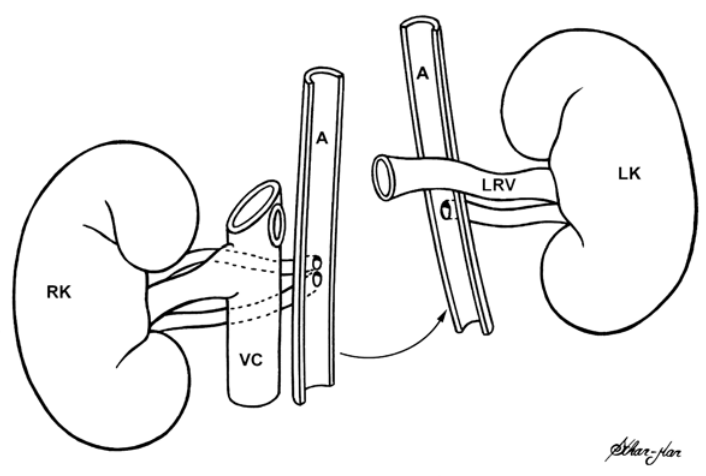
Figure 1 – Folding longitudinal split aorta and separation of cadaveric kidneys leaving vena cava intact attached to the right renal vein. RK = right kidney, LK = left kidney, A = aorta, VC = vena cava, LRV = left renal